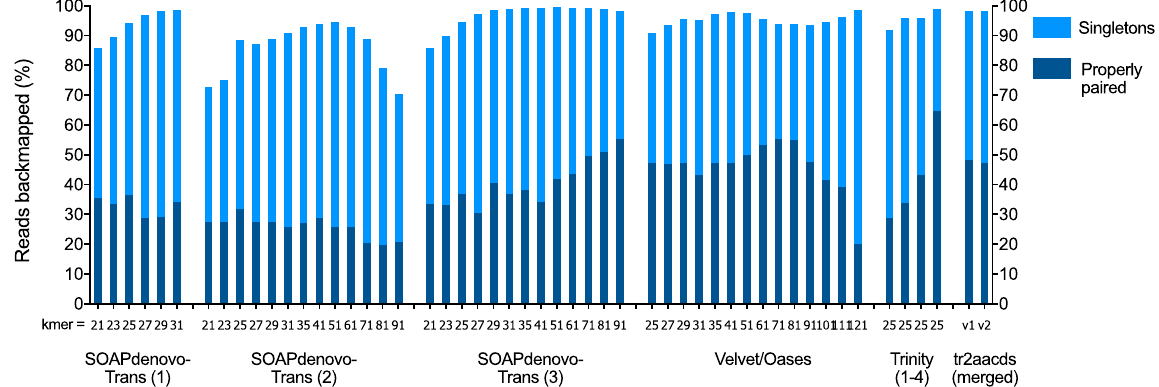
Figure 4. Proportion of reads backmapping to each transcriptome assembly. SOAPdenovo-Trans (1): no filtering; (2): light filtering of poor quality read pairs, combined with in silico normalization; (3): moderate filtering of poor quality read pairs; Velvet/Oases: moderate filtering of poor quality read pairs; Trinity (1): light filtering of poor quality read pairs, combined with in silico normalization; (2): light filtering of poor quality read pairs, combined with SEECER error correction; (3): moderate filtering of poor quality read pairs; (4): moderate filtering of poor quality reads and SEECER error correction; tr2aacds merged assemblies (1): pre-v2.3.2 Trinity; (2): including v2.3.2